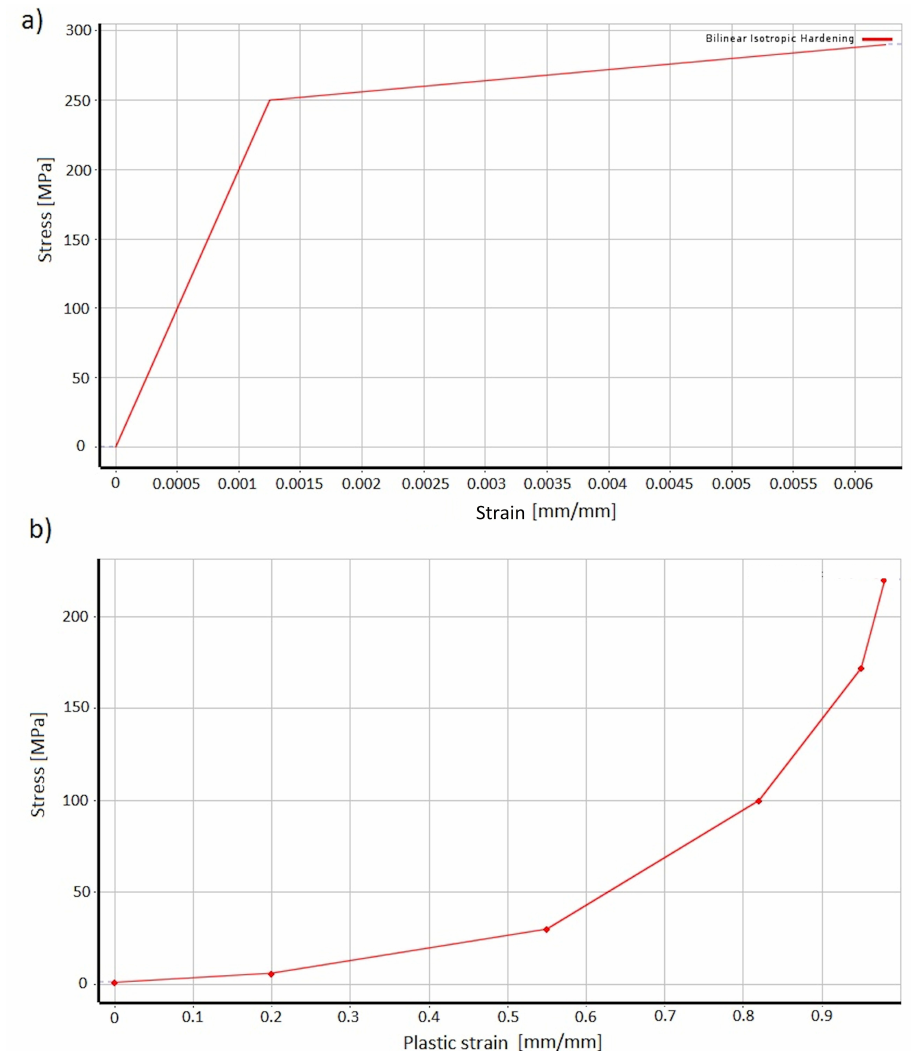
Figure 7: Characteristics of the materials: a) isotropic bilinear model of steel, b) isotropic multilinear model of expanded